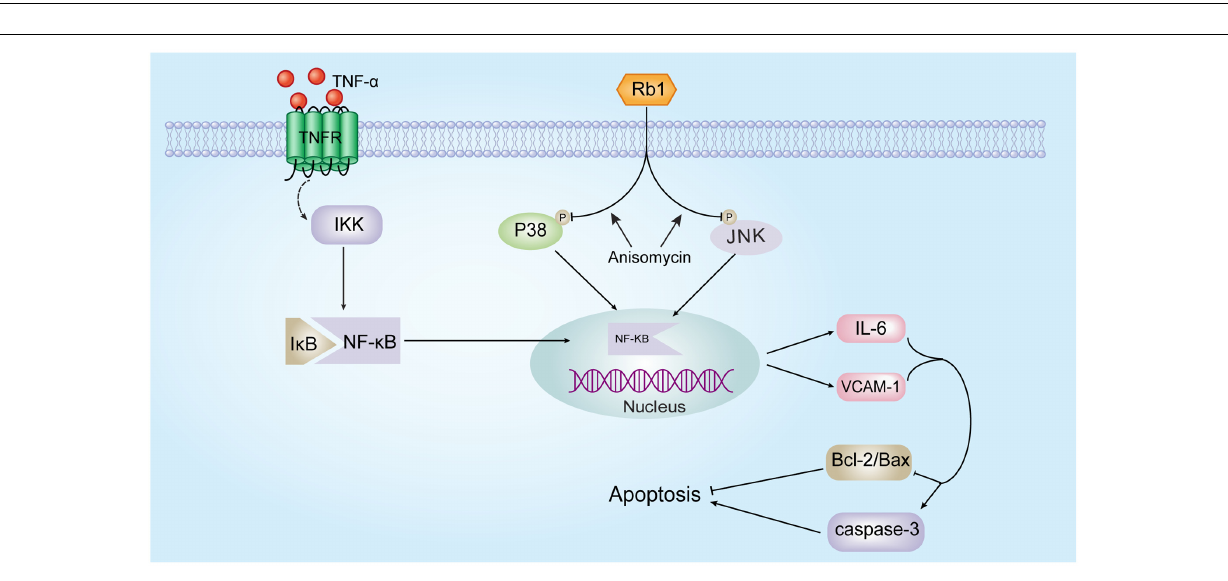
FIGURE 8 | Schematic of the mechanism by which ginsenoside Rb1 prevents TNF- α -induced inflammation in